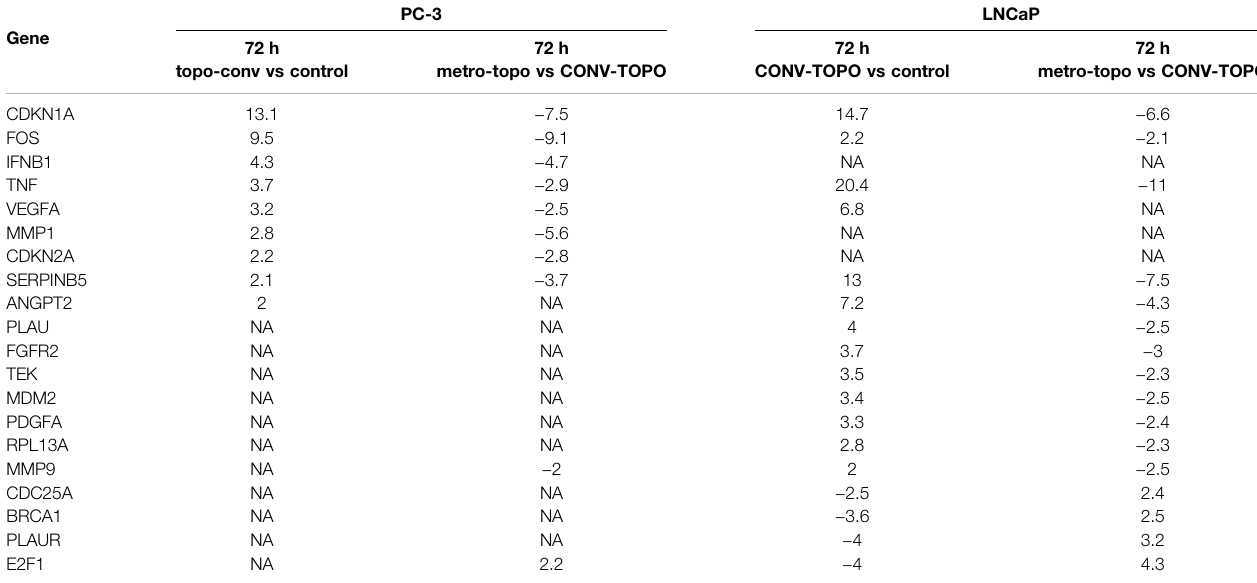
TABLE 2 | Top differentially expressed genes (DEGs) (fold change compared to untreated) following 72 h of CONV- or METRO-TOPO treatment in PC-3 (mCRPC/NEPC) and LNCaP (metastatic, castration-sensitive PCa) cell lines. Fold change cut-off value is > 2. CDKN1A, FOS, TNF and SERPINB5 were expressed in both treatment groups but there was variation in expression levels as these genes were downregulated in the METRO treatment group and upregulated in the CONV